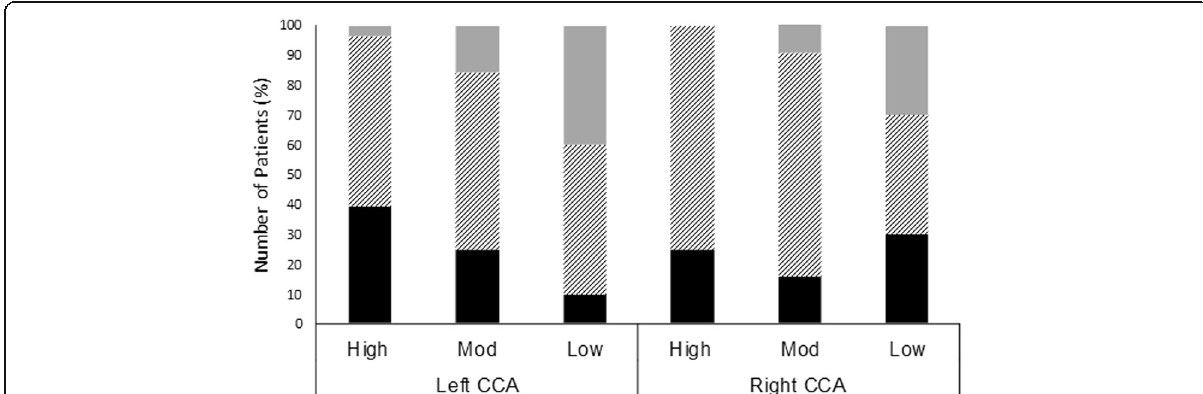
Fig. 2 Left- and right-side common carotid artery plaque severity in patients with high, moderate, and low cardiorespiratory fitness. Black bars indicate the proportion of patients with plaques < 1 mm and diagonal lines indicate the proportion of patients with plaques between 1 and 3 mm. Grey bars indicate the proportion of patients with plaques > 3 mm. Mod = moderate; CCA = common carotid